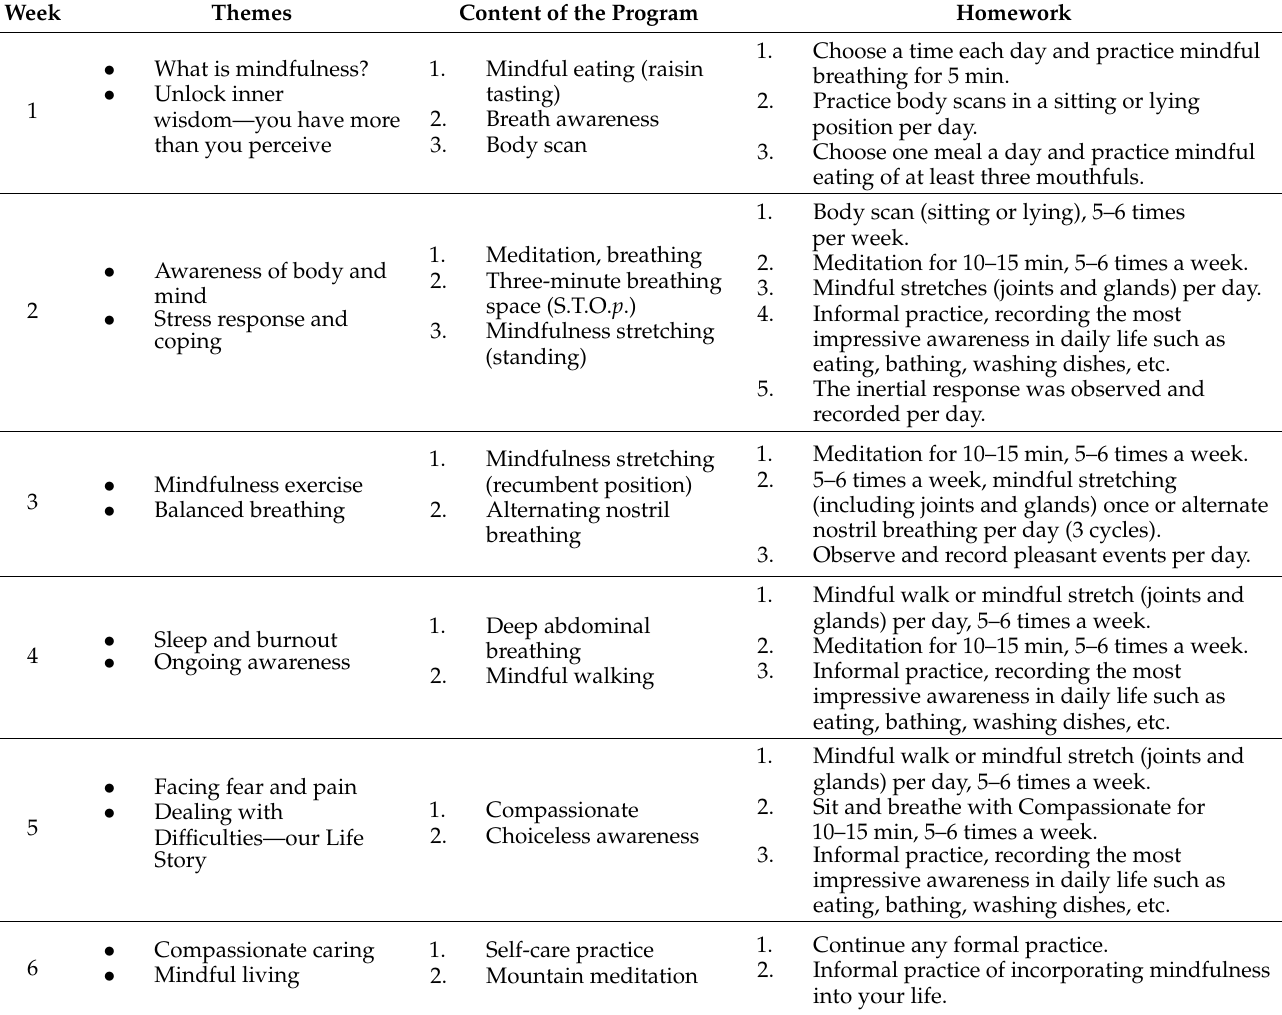
Table 1. MBSR program in the